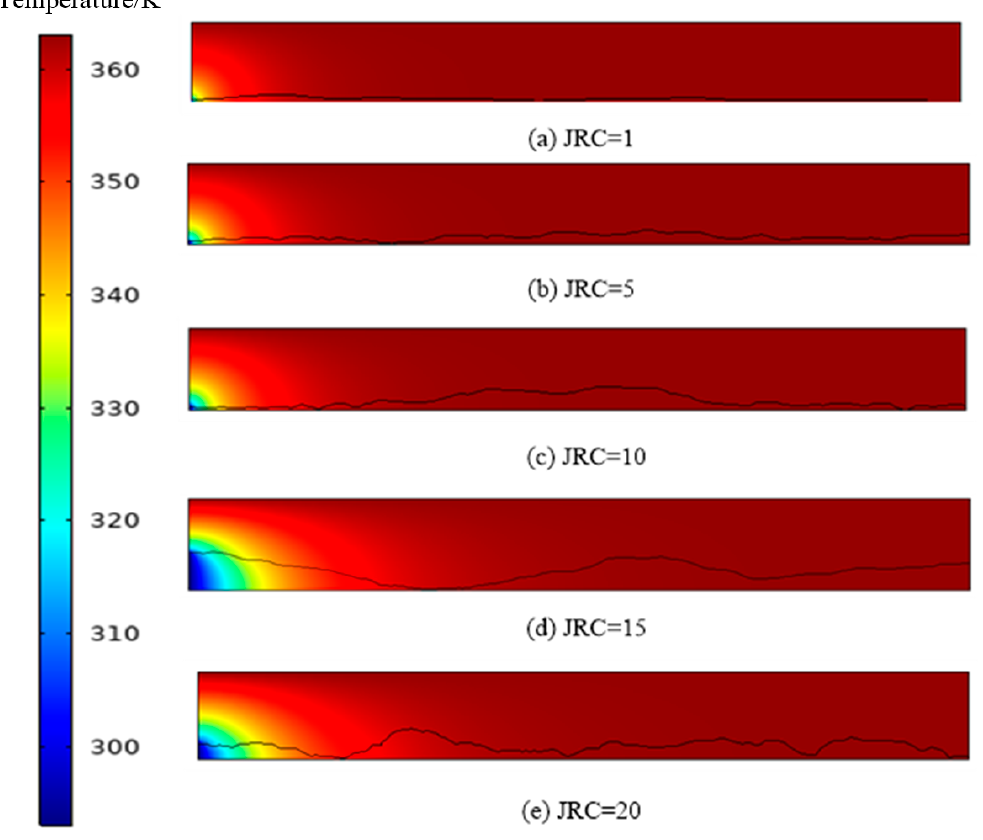
Figure 5. Temperature contour of fracture profile with different JRC (1–20).